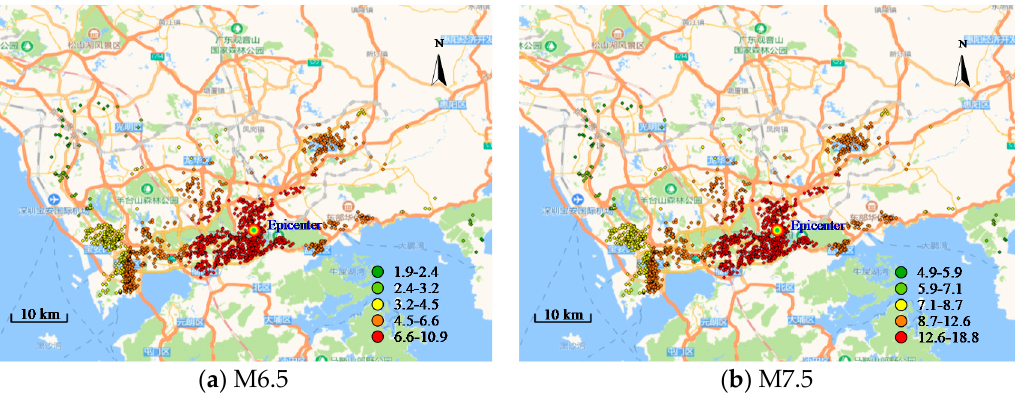
Figure 15. Distributions of ground motion intensity parameter Sa_0.3 s (m ∙ s -2 ): ( a ) M6.5; ( b ) M7.5.